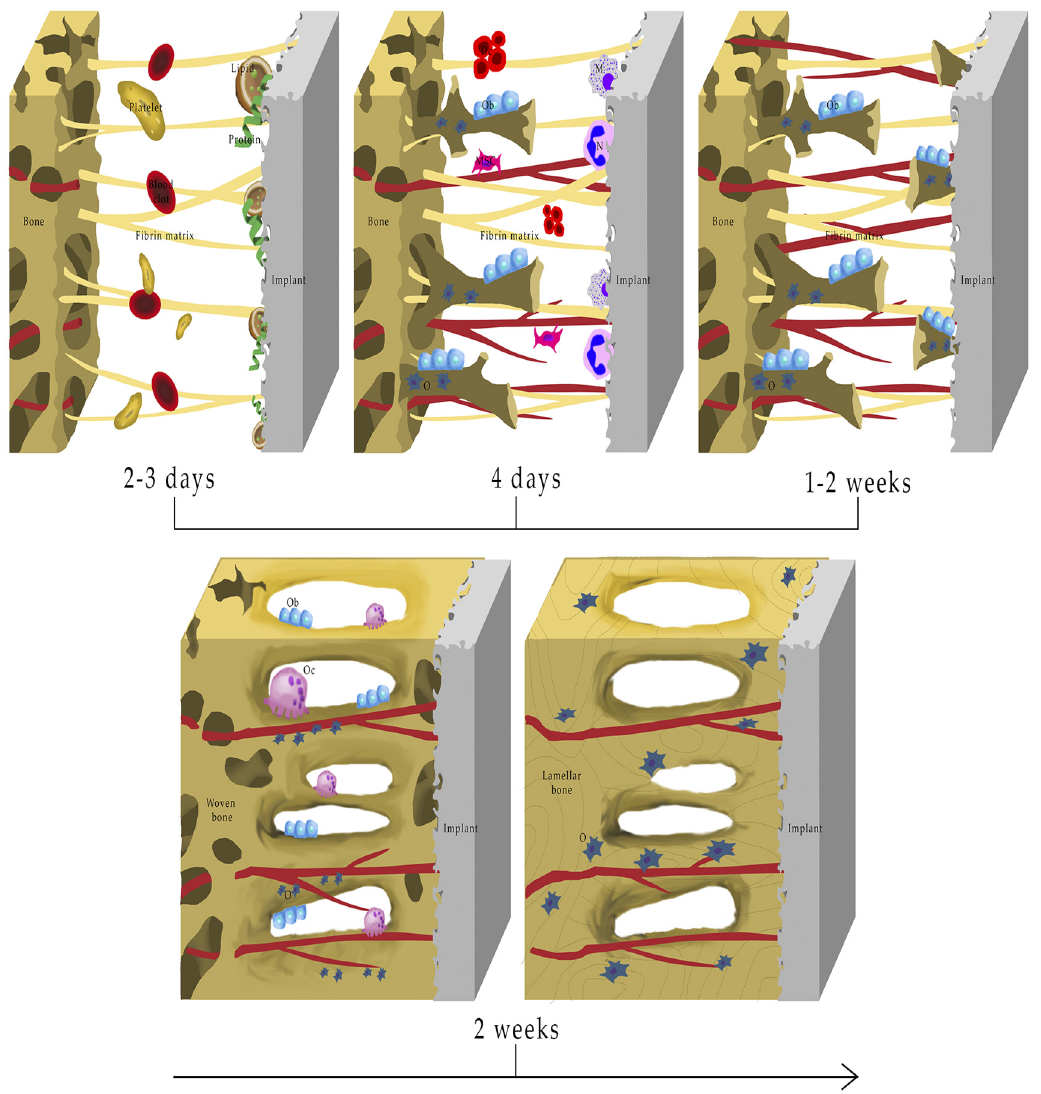
Figure 2. Interaction between biomaterials and